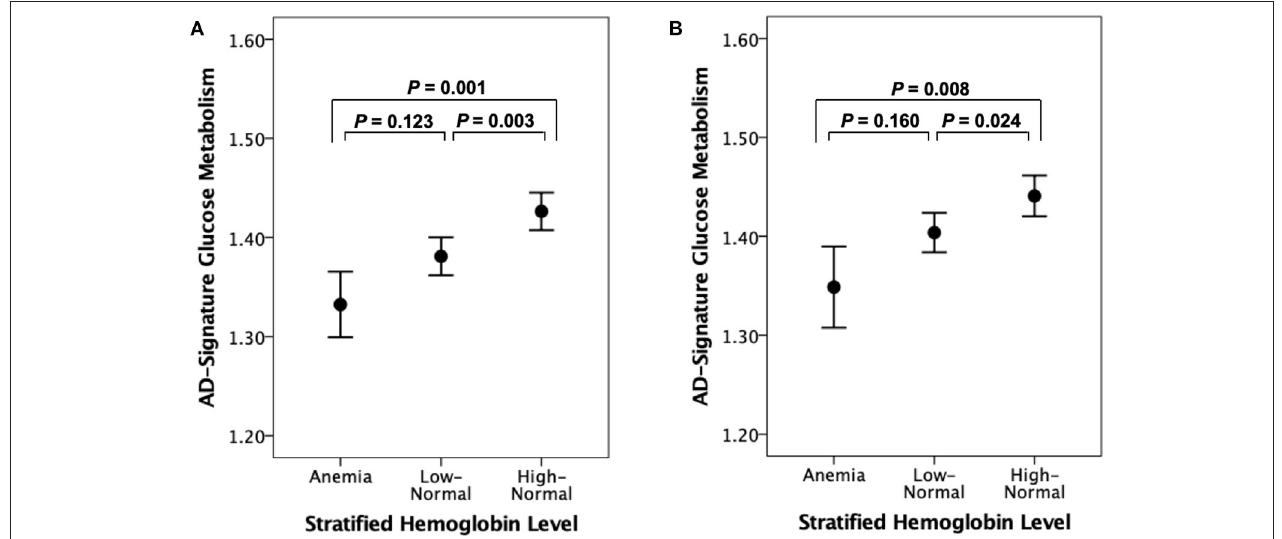
FIGURE 2 | Error bar charts displaying AD-signature cerebral glucose metabolism and stratified hemoglobin level in (A) non-demented and (B) cognitive normal older participants. Error bars indicate standard error. Multiple linear regression analyses were performed after adjusting for age and sex.